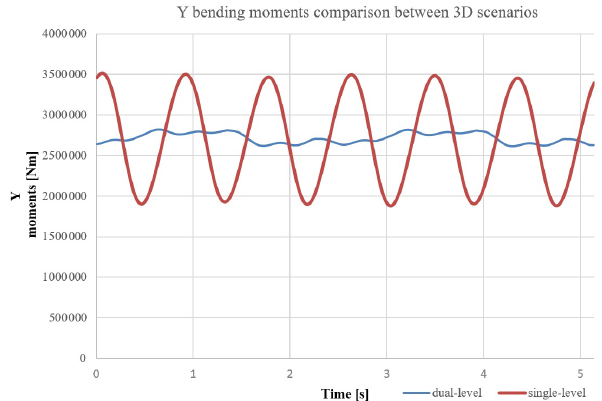
Figure 10. Y -bending moments comparison between 3D scenarios.